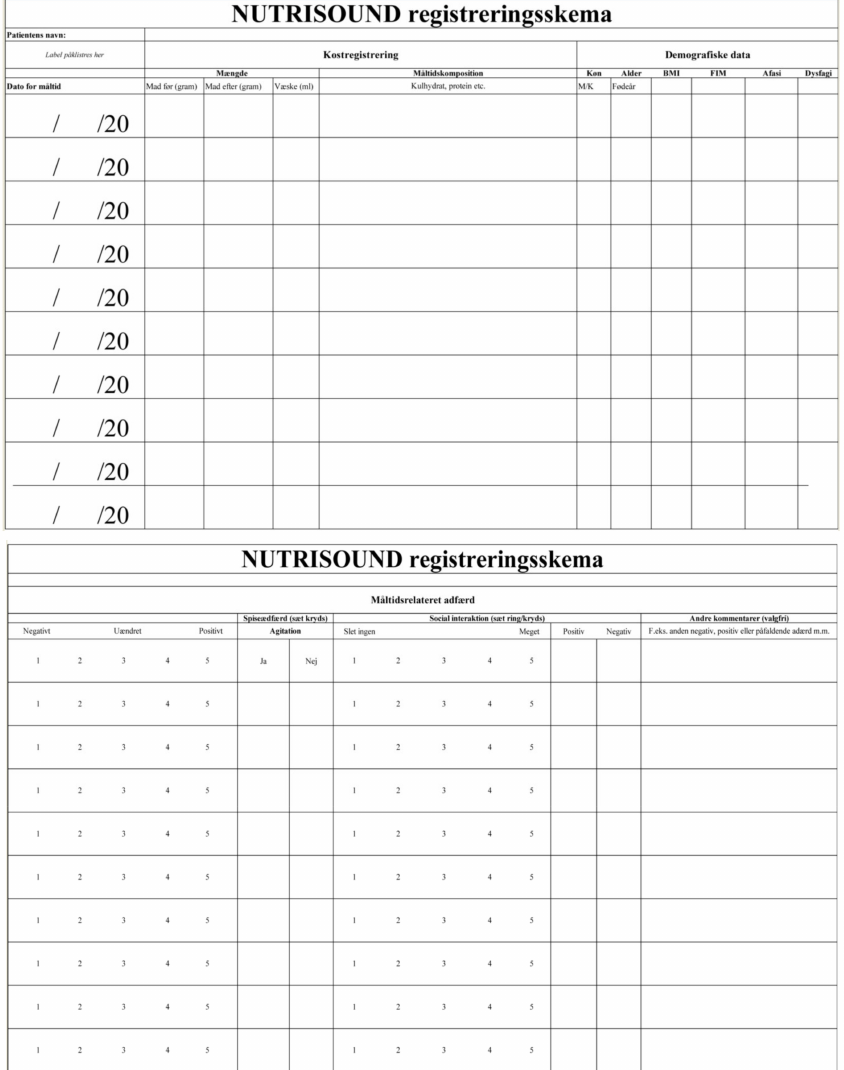
Figure A1. Mealtime observation